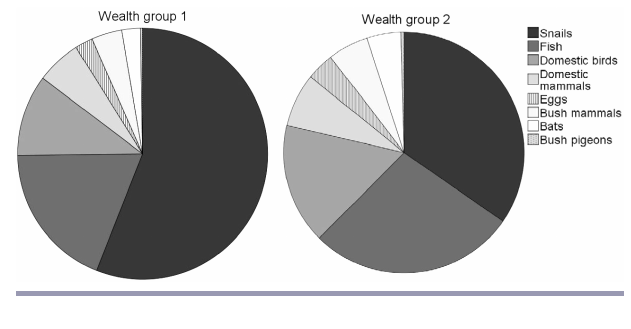
Fig. 4 . Proportion in diet of each food type for considered wealth group: (1) lower wealth indicators, (2) higher wealth indicators.